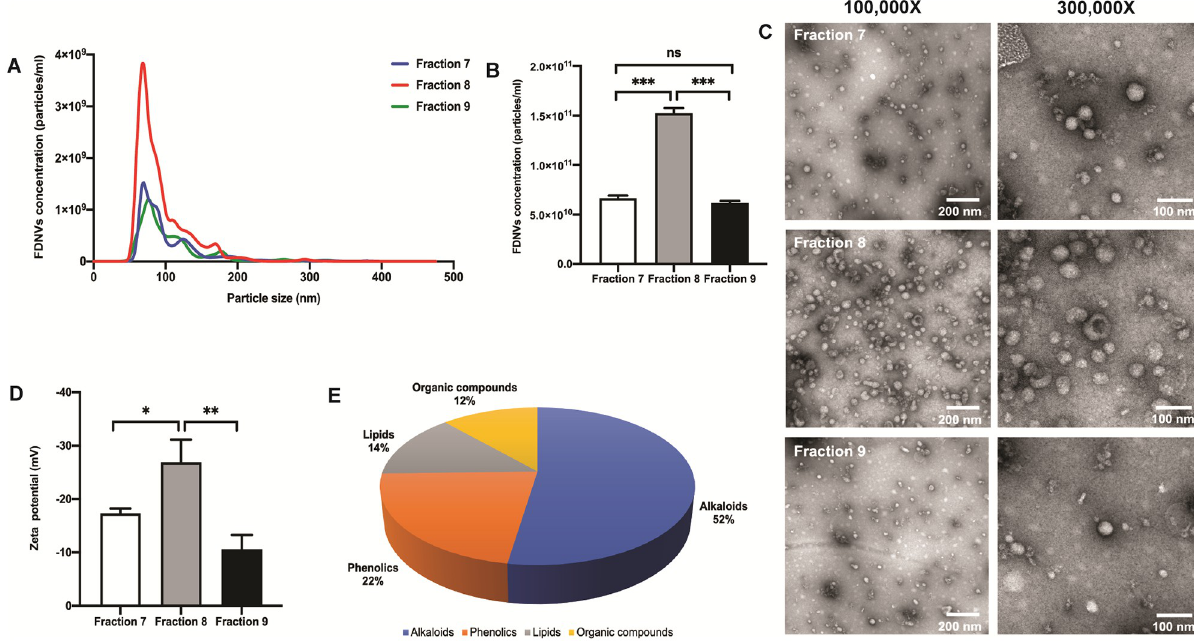
Fig 1. Characterization of FDNVs. (A) The size distribution and (B) particle concentration of fractions 7, 8, and 9 were analyzed by NTA. (C) FDNV morphology was observed under TEM at 100,000X (scale bar = 200 nm) and 300,000X (scale bar = 100 nm). (D) The zeta potential of isolated FDNVs was measured using a Zetasizer. (E) Distribution of tentatively identified metabolites in FDNVs using LC-MS/MS. Data are represented as means ± SD of three independent experiments in duplicate; ns = not significant. � P < 0.05, �� P < 0.01, ��� P < 0.001 (one-way ANOVA).